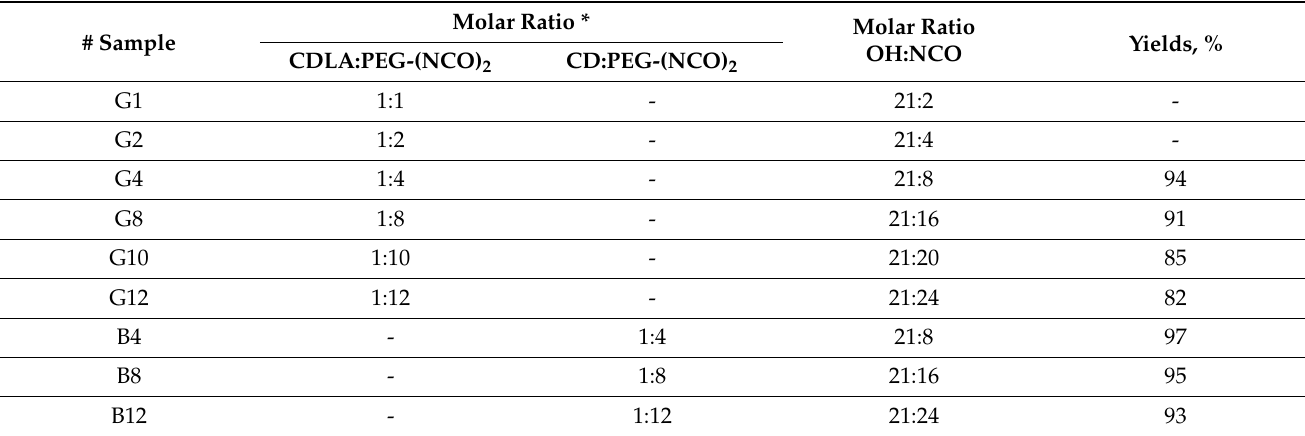
Table 1. Synthesis parameters of CDLA-PEG (G series) and CD-PEG hydrogels (B series).